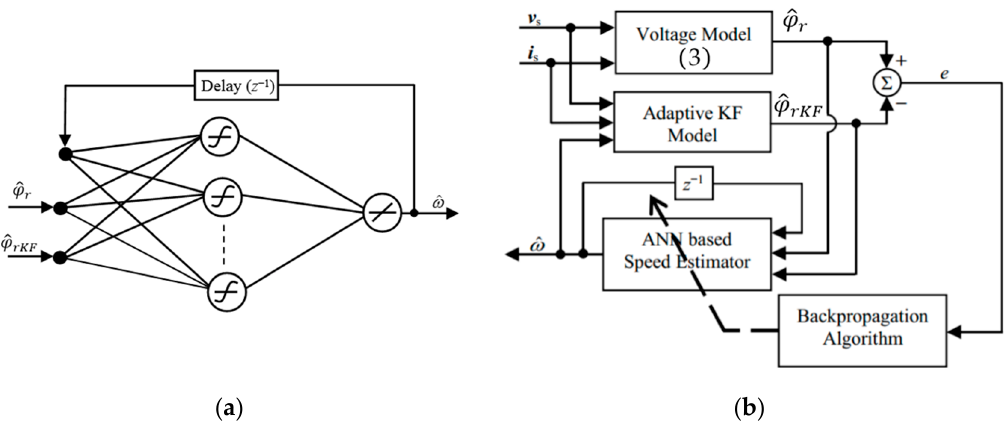
Figure 2. ANN based speed estimation: ( a ) ANN structure; ( b ) estimation and ANN training scheme. Energies 2020 , 13 , x FOR PEER REVIEW